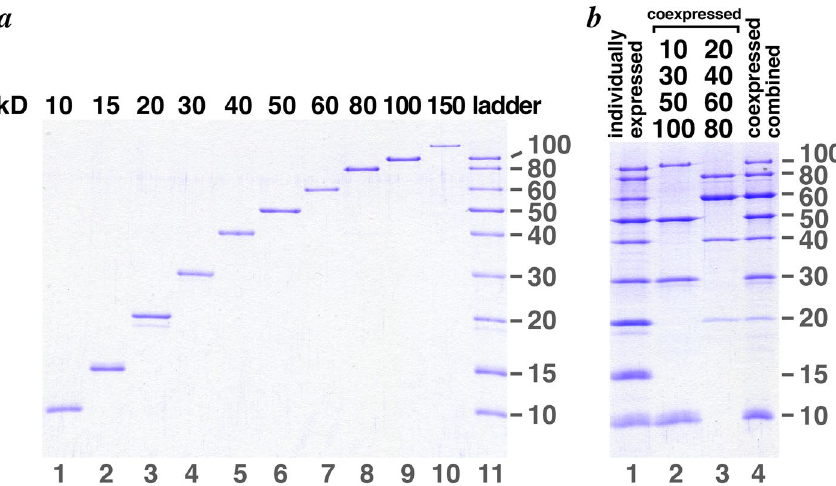
Figure 3. The Penn State ladder proteins, individually expressed or coexpressed. ( a ) The same metal affinity purified individual proteins presented in Fig. 2 are shown in lanes 1 through 10. Lane 11 shows the 10-100 kD ladder assembled from the same samples shown in lanes 1 through 9 at the same concentrations. Individual proteins from the most concentrated metal affinity fractions were diluted with protein gel loading buffer as shown in parentheses: 10 kD (1:80), 15 kD (1:120), 20 kD (1:160), 30 kD (1:60), 40 kD (1:120), 50 kD (1:120), 60 kD (1:80), 80 kD (1:80), 100 kD (1:120), 150 kD (1:20). ( b ) Coexpressed Penn State ladder proteins. Lane 1 shows a ladder assembled from individually expressed and purified ladder proteins similar to that in panel (a) lane 11. Lane 2 shows the metal affinity purified coexpressed 10, 30, 50 and 100 kD ladder proteins (1:30 dilution of original fraction shown as 1:4 dilution in Fig. 5a, lane 6), while lane 3 shows the equivalent for the coexpressed 20, 40, 60 and 80 ladder proteins (1:20 dilution of original fraction shown as 1:4 dilution in Fig. 5b, lane 5). Lane 4 shows the coexpressed 10-100 kD ladder assembled by mixing the coexpressed 10, 30, 50, 100 kD and the coexpressed 20, 40, 60, 80 kD metal affinity